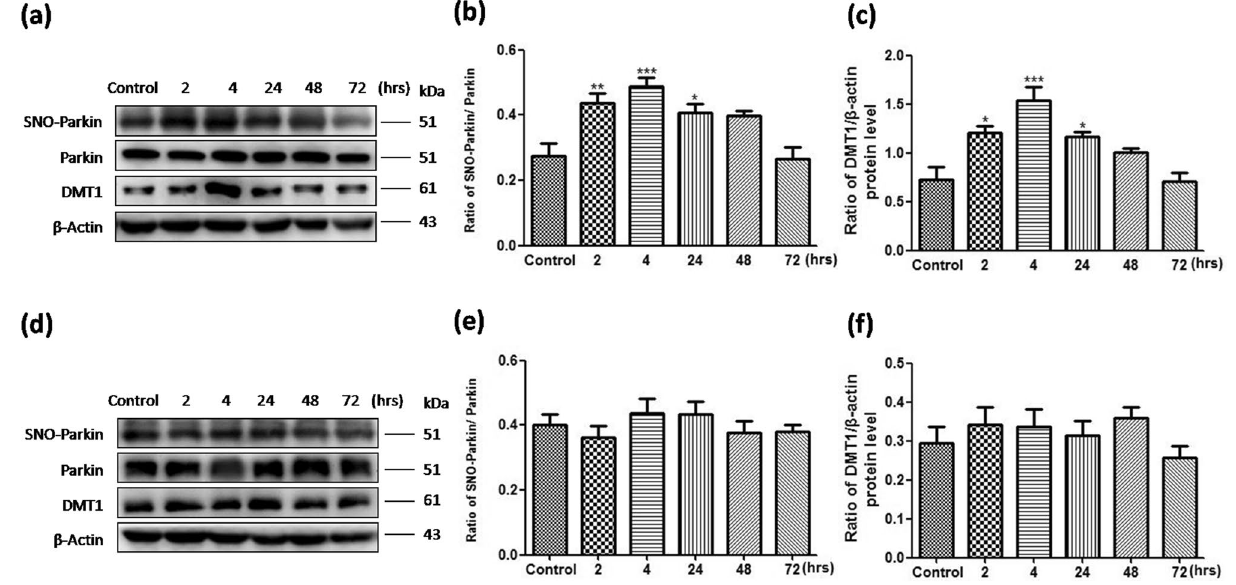
Figure 7. In PD mice, the protein levels of SNO-parkin and DMT1 in substantia nigra were changed. ( a ) The expression of SNO-parkin and DMT1 protein in substantia nigra was detected in MPTP induced PD mice. ( b ) Statistical analysis for changes in levels of SNO-parkin. ** P = 0.001, 2 h versus control; *** P = 0.0008, 4 h versus control; * P = 0.03, 24 h versus control. ( c ) Statistical analysis for changes in levels of DMT1. * P = 0.02, 2 h versus control; *** P = 0.0007, 4 h versus control; * P = 0.04, 24 h versus control. ( d ) The expression of SNO-parkin and DMT1 protein in striatum was detected in MPTP induced PD mice. ( e ) Statistical analysis for changes in levels of SNO-parkin. P = 0.611. ( f ) Statistical analysis for changes in levels of DMT1. P = 0.472. N =